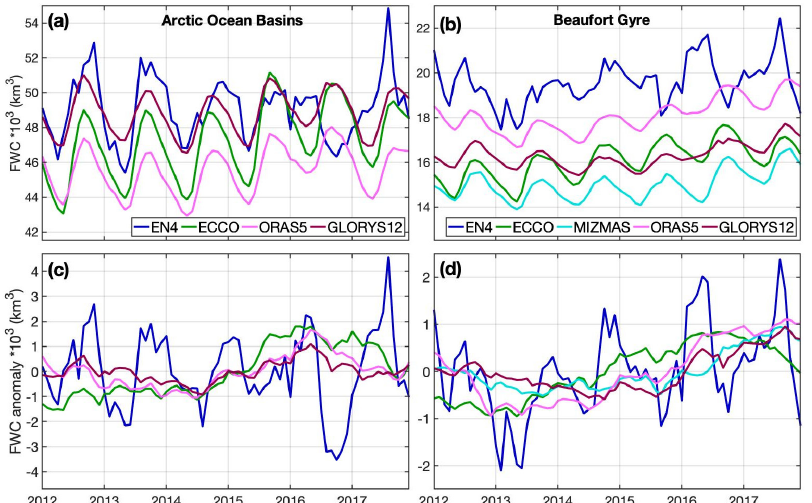
Figure 13. Timeseries of depth-integrated (5 m–500 m) and box–accumulated freshwater content (FWC; km 3 ) in the ( a , c ) Arctic Ocean Basins (180°W–180°E, 67°N–90°N) and the ( b , d ) Beaufort Gyre (170°W–130°W, 70.5°N–80.5°N) from (top panel) raw data and the (bottom panel) departure from the monthly climatology between 2012 and 2017.